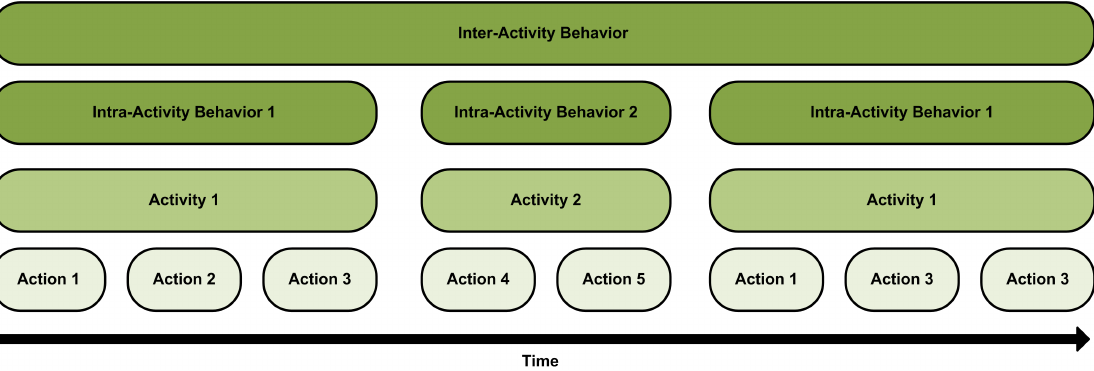
Figure 1. Elements of the user